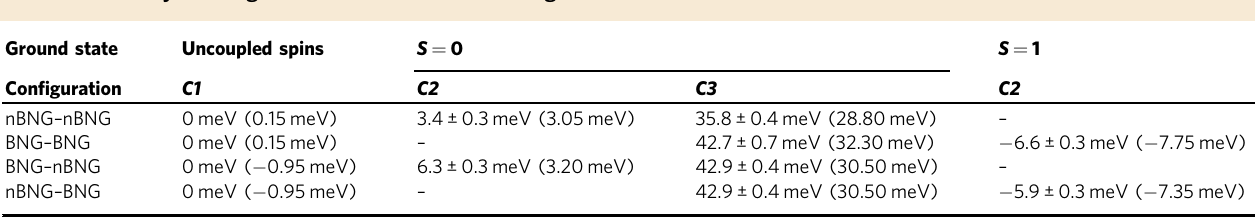
Table 1 Summary of the ground state of all dimer con fi gurations.